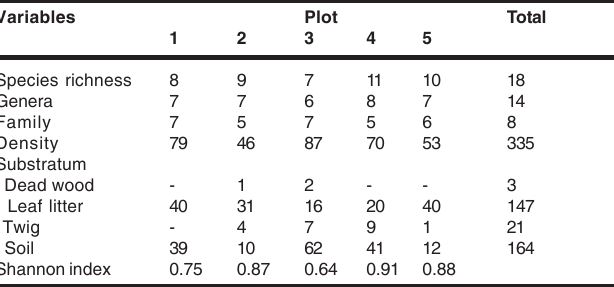
Table 1. Total species richness and density of macrofungi in five plots of man-made Pitchandikulam Forest, southern